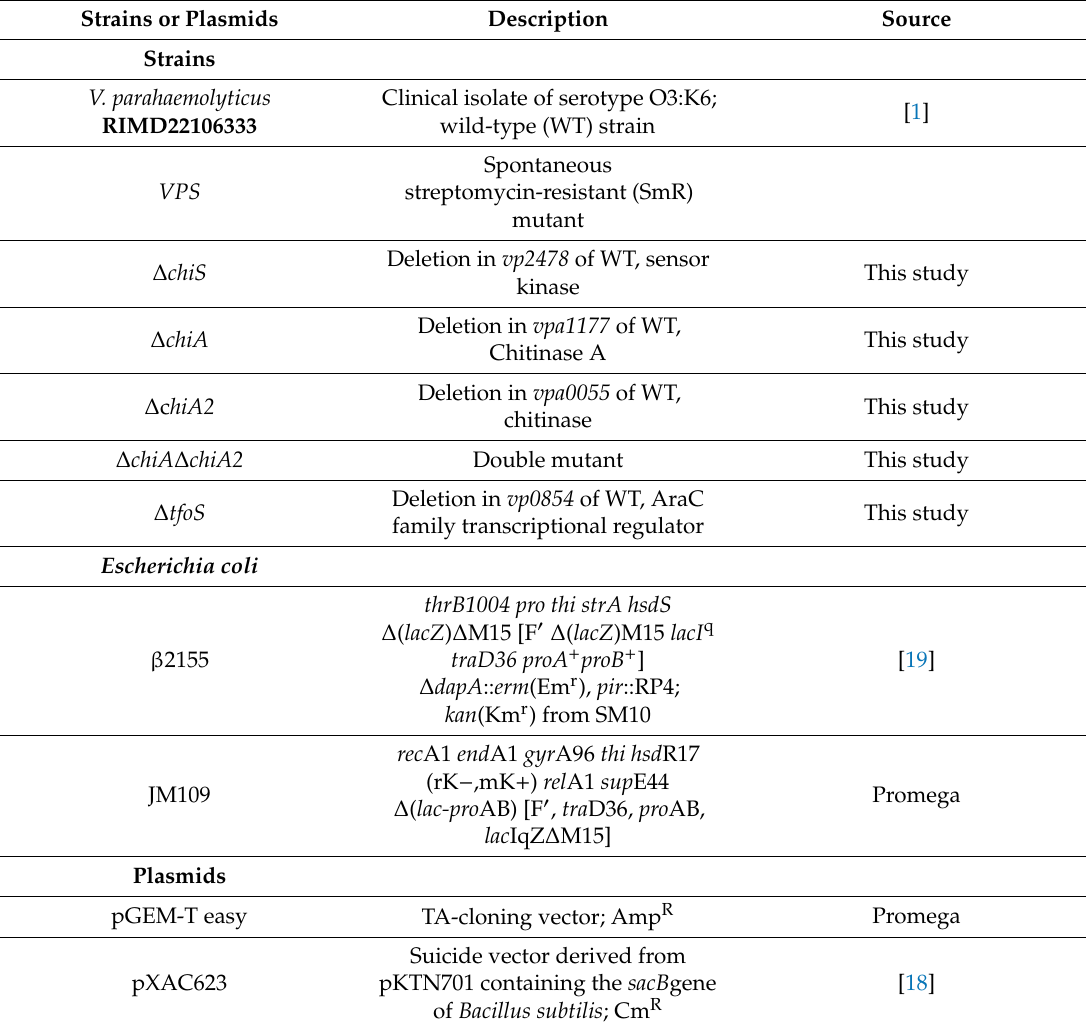
Table 1. List of strains and plasmids used in this